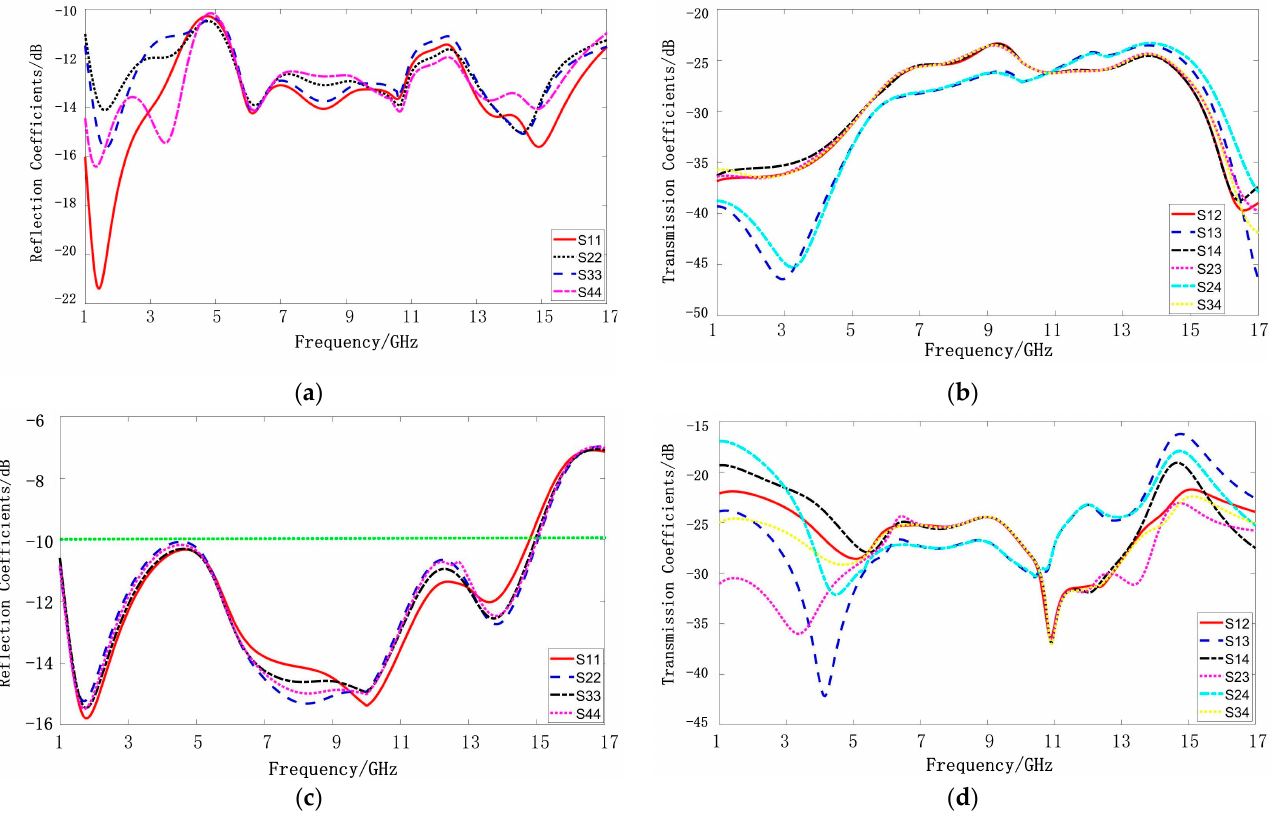
Figure 9. S-parameters of the four ports of the UWB MIMO antenna: ( a ) reflection coefficient with strips; ( b ) transmission coefficient with strips; ( c ) reflection coefficient without strips; ( d ) transmission coefficient without strips.